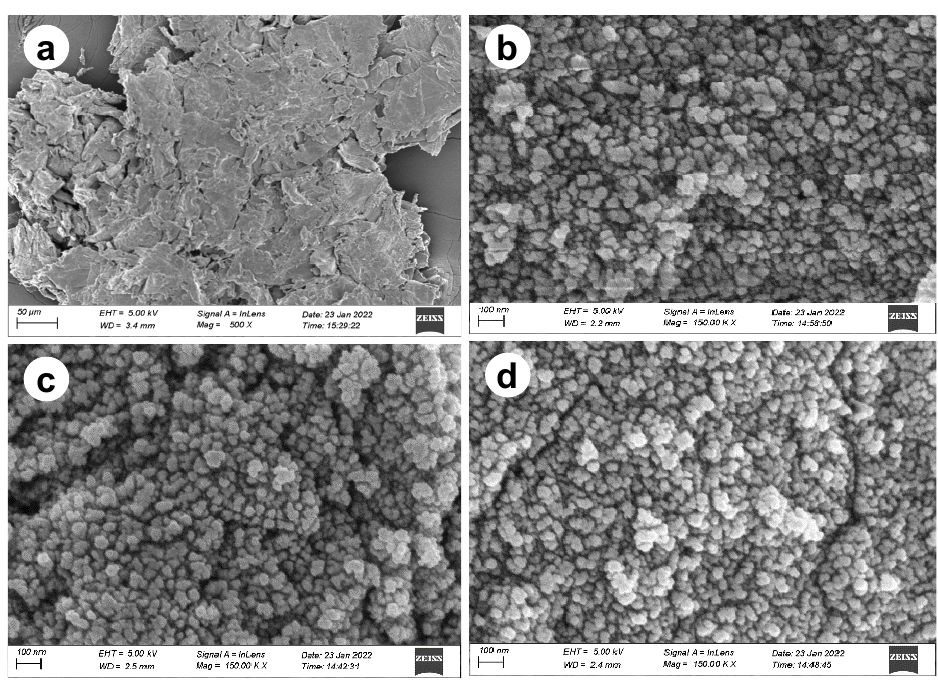
Figure 6. SEM image of ( a ) cellulose, ( b ) MIO-NPs, ( c ) SCB/MIO-NCPs, and ( d ) WTP/NCPs. The formation of MIO-NPs, WTP/MIO-NCPs, and SCB/MIO-NCPs was investigated by EDX analysis, and the relative elemental compositions (C, O, and Fe) are presented in Figure 7. In cellulose, the presence of carbon (C) and oxygen (O) was confirmed by the EDX analysis (Figure 7a). The sharp peaks at 6.4 keV and 0.5 keV in the EDX spectrum indicated the existence of elemental iron (Fe) and oxygen (O), respectively, for the MIO-NPs (Figure 7b) [36]. Similarly, the presence of intense peaks for elemental C, O, and Fe in Figure 7c,d confirmed the insertion of MIO-NPs into the cellulose matrix and the formation of SCB/MIO-NCPs and WTP/MIO-NCPs.